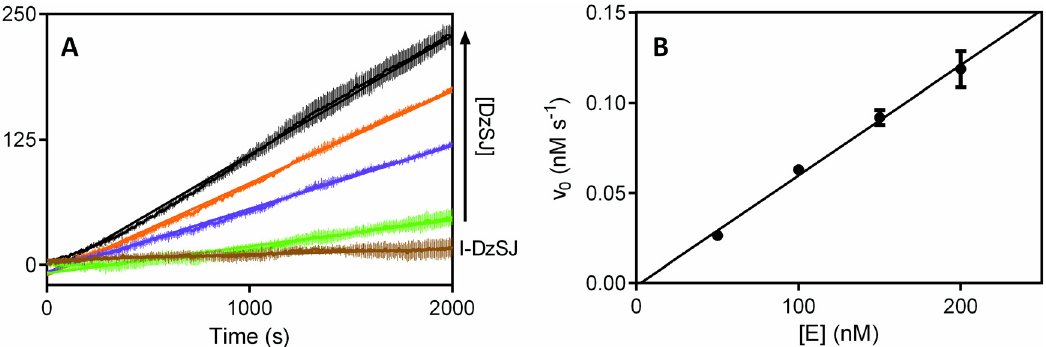
Fig 4. Phosphate release assay for ‘ 10 – 23 ’ DNAzyme steady state kinetics. Reactions were set up containing 2 μ M RNA substrate, 1 μ M MDCC-PBP, 0.3u/ μ l T4PNK and varying concentrations (50, 100, 150 and 200 nM) of DzSJ in 40 mM Tris-HCl (pH 7.5), 20 mM MgCl2 and 50 mM NaCl at room temperature. As a control 200 nM inactive DzSJ was used instead of DzSJ. Cleavage of RNA substrate exposes a 2 ’ , 3 ’ -cyclic phosphate ( > P). The cyclic phosphate is released by T4PNK and quantified by fluorescence increase caused by P i binding to MDCC-PBP. Background measured in parallel of a reaction without enzyme was subtracted from each data set. Fluorescence increase was converted to [P i ] by interpolation from standard curve (S6 Fig). (A) Inorganic phosphate concentration plotted over time. Data points are shown as bars of standard error of the mean of three independent experiments. Arrow ( " ) refers to the increasing concentration of DzSJ in the different data sets. (B) Initial velocities (v 0 ) obtained from (A) plotted against DzSJ concentration showing a linear relation. R 2 = 0.98.